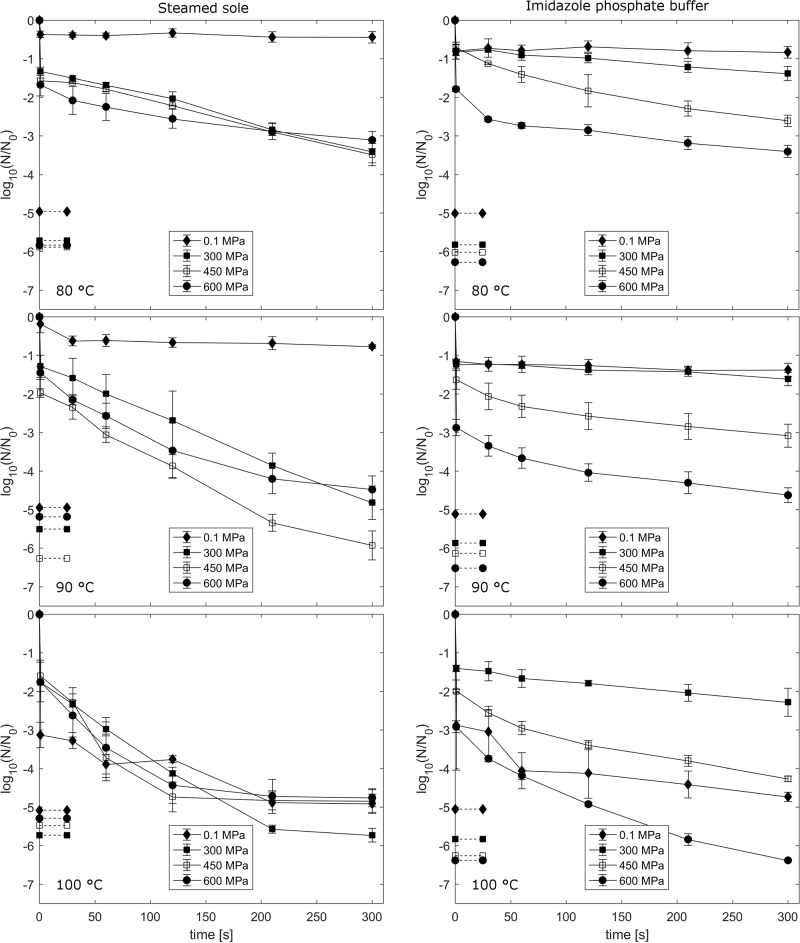
Log reduction of C. botulinum TMW 2.990.Spores suspended steamed sole and IPB after treatments at 90–100 °C and 0.1–600 MPa for 1–300s. Dashed lines indicate the corresponding detection limits. Initial spore count: 106–108 spores/g. Data are shown as means ± standard deviations of three independent experiments.